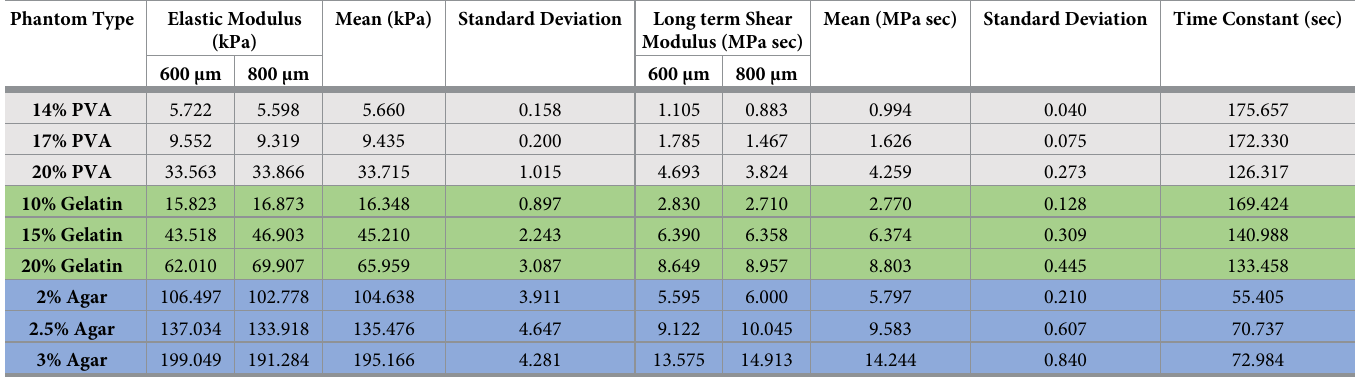
Table 1. Mean elastic modulus, long term shear modulus, and time constant data, including standard deviation of the mean, for each type of TMP: PVA, gelatin, and agar.